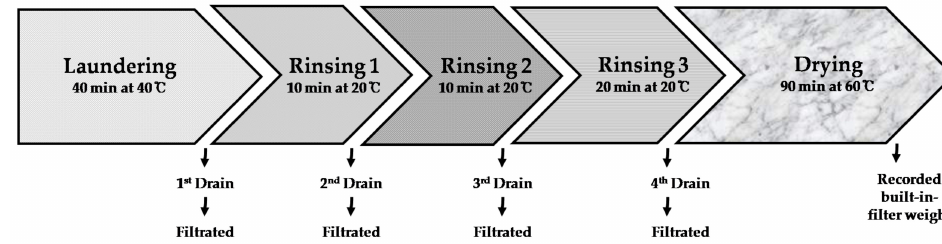
Figure 3. Washing procedures during one standard washing course and drying